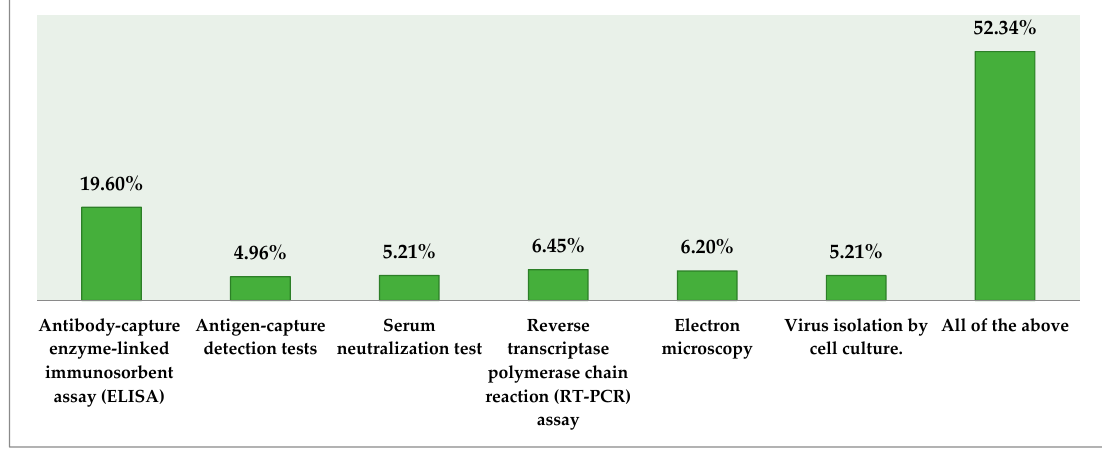
Figure 5. Respondents’ opinion regarding diagnostic tools for EVD.